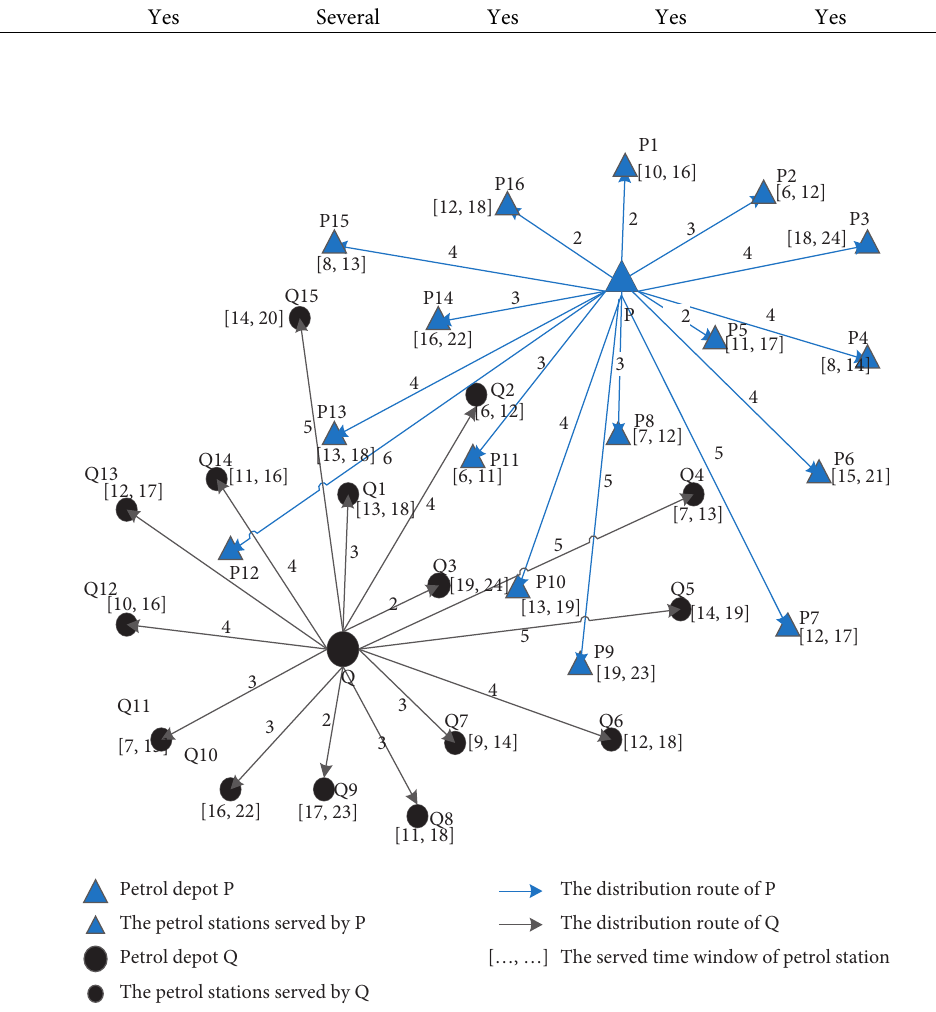
Figure 1: Noncooperative petrol distribution